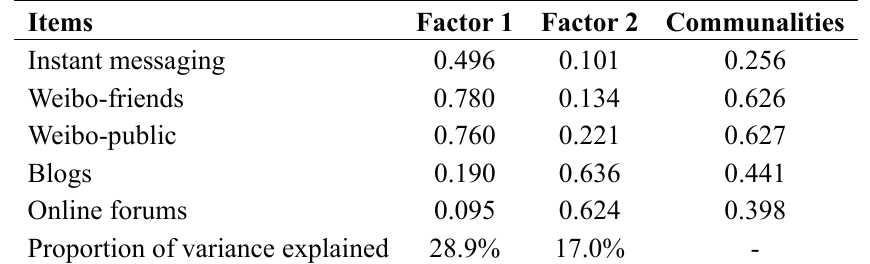
Table 3. Exploratory factor analysis of five-item preference for using social media.